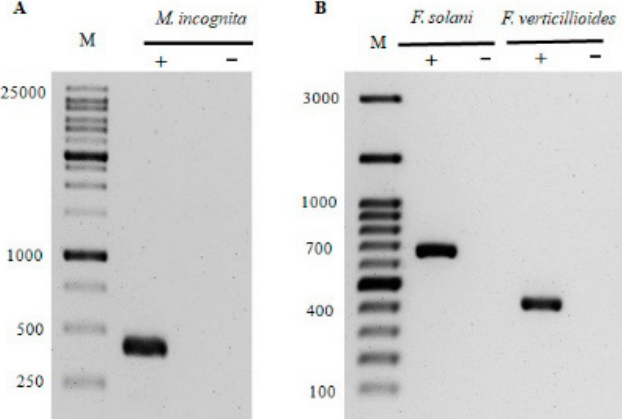
Fig. 2: Gel electrophoresis after PCR reaction: A) PCR reaction, Carril 1: 250-bp molecular marker (Invitrogen, USA), Carril 2: 399 bp frag- ment of Meloidogyne incognita DNA , Carril 3: (-) negative control reaction, no DNA was added; B) PCR reaction, Carril 1: 100-bp molecular marker (Invitrogen, USA), Carril 2: 658 bp fragment of Fusarium solani DNA, Carril 3: (-) negative control reaction, no DNA was added, Carril 4: 400 bp fragment of F. verticillioides DNA, Carril 5: (-) negative control reaction, no DNA was